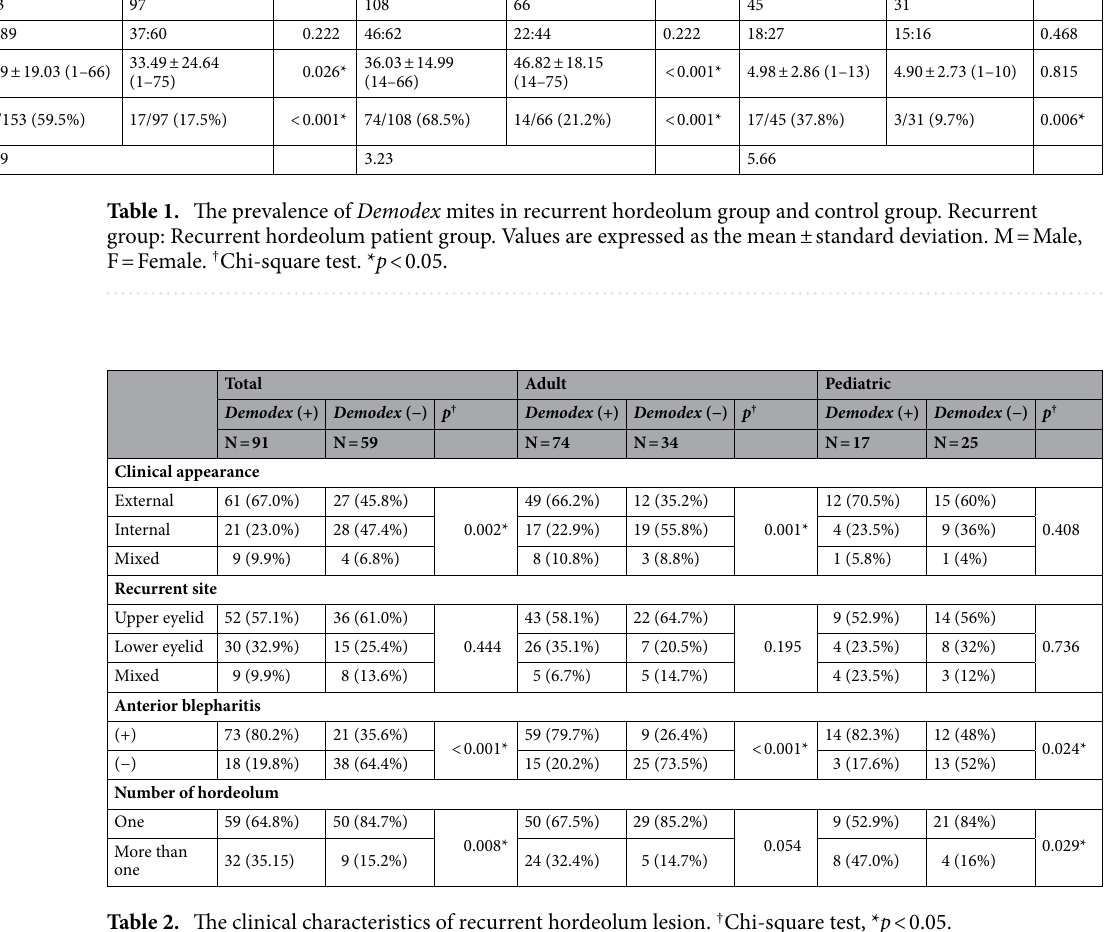
Table 2. The clinical characteristics of recurrent hordeolum lesion. † Chi-square test, * p < 0.05.